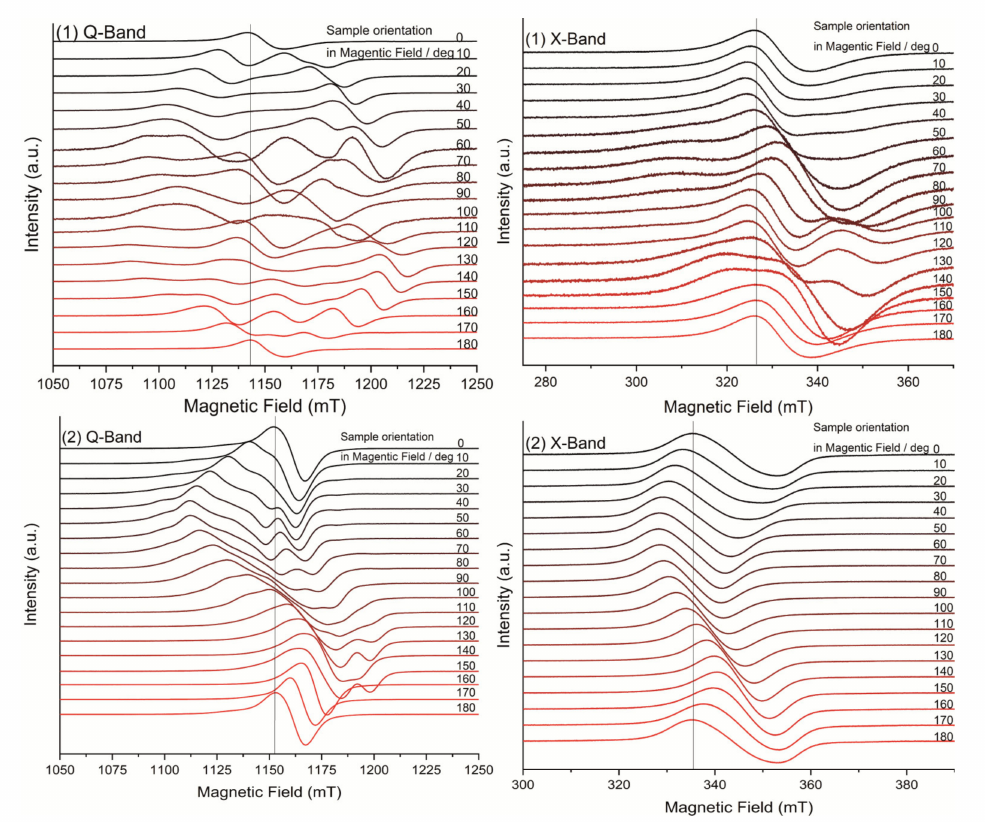
Figure 3. EPR spectra in Q-band and X-band with rotation along the main magnetic field of complex ( 1 ) ( top ) and complex ( 2 ) ( bottom